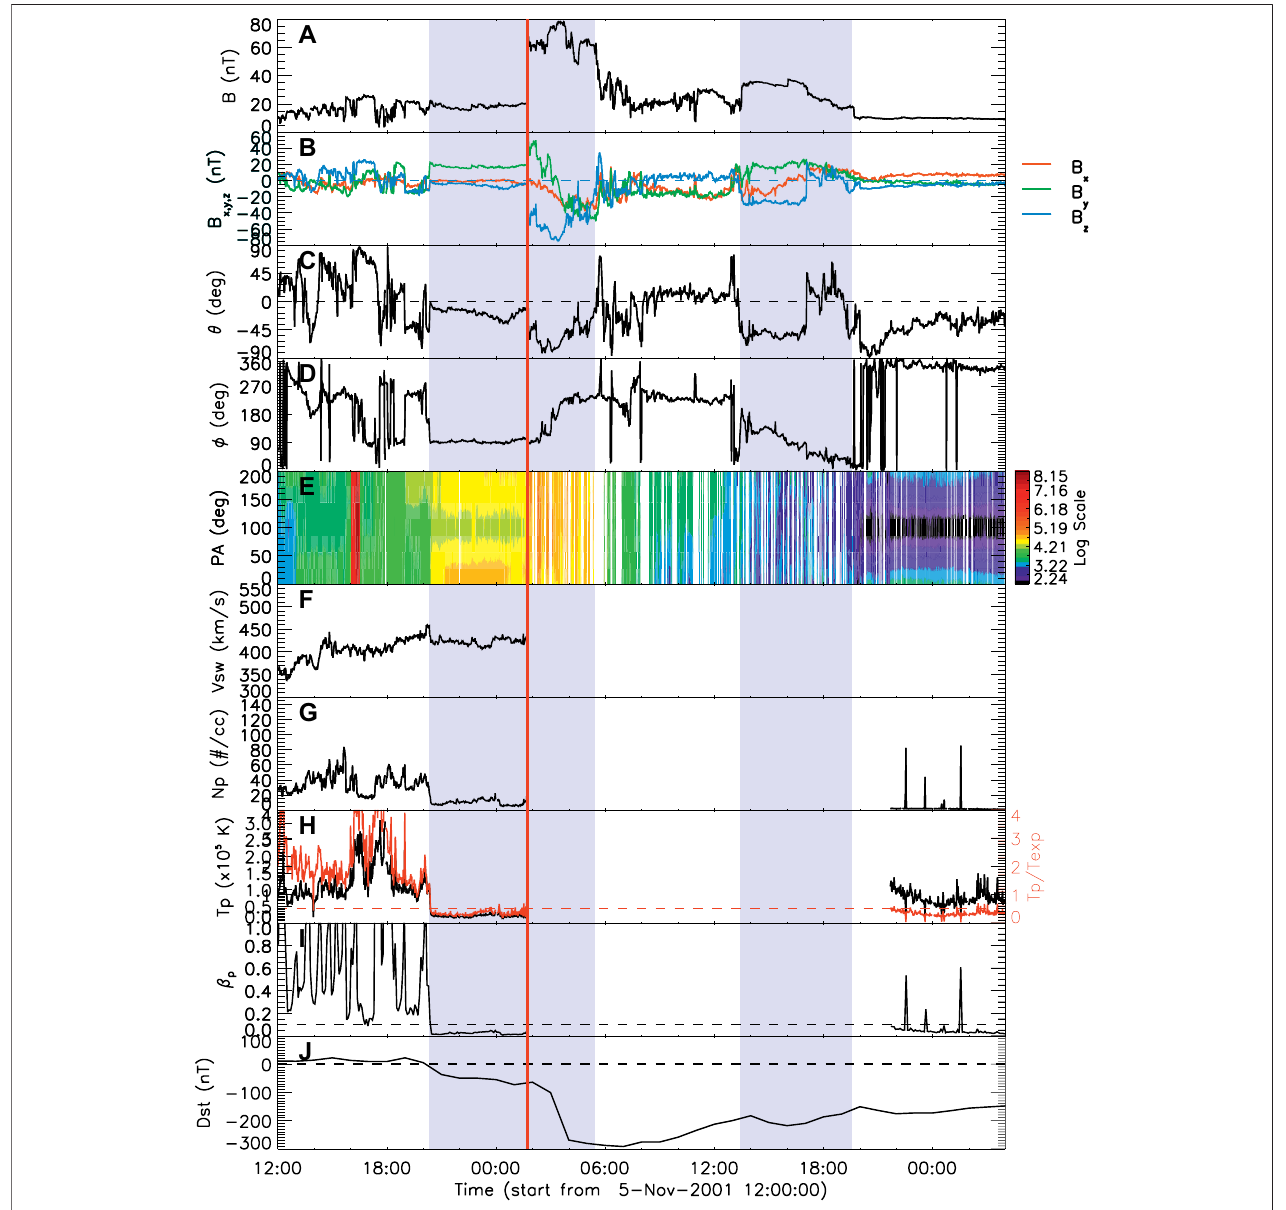
FIGURE 3 | Wind observations from 2001 November 5 12:00 to 2001 November 7 04:00. The panels are the same as in Figure 1 .